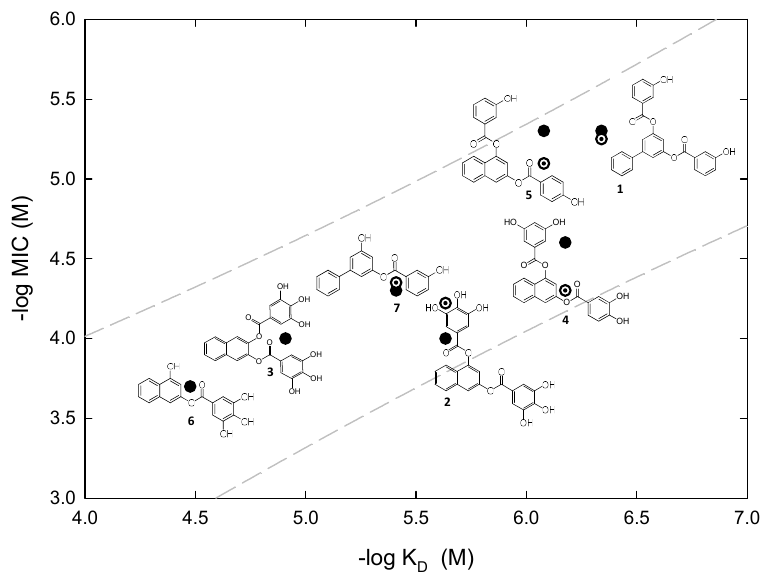
Figure 3. Correlation of antimicrobial activity (MIC) with binding affinity ( K D ) of inhibitor binding to the BsFtsZ nucleotide site. Data from representative analog compounds are shown together with their chemical structures. Filled circles, B. subtilis MIC; dotted circles, methicillin-resistant S. aureus MIC. The dashed lines are the 95% predictive intervals for B. subtilis MIC vs K D values of 36 analogs (adapted with permission from [56]; copyright 2015 American Chemical Society).